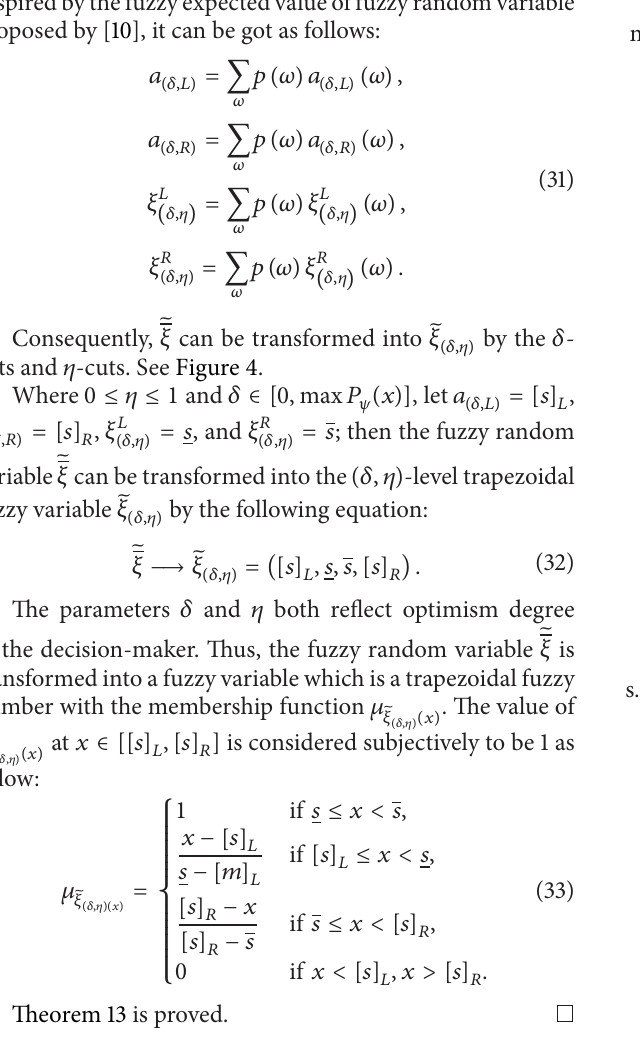
Figure 4: The transformation process from fuzzy random variable